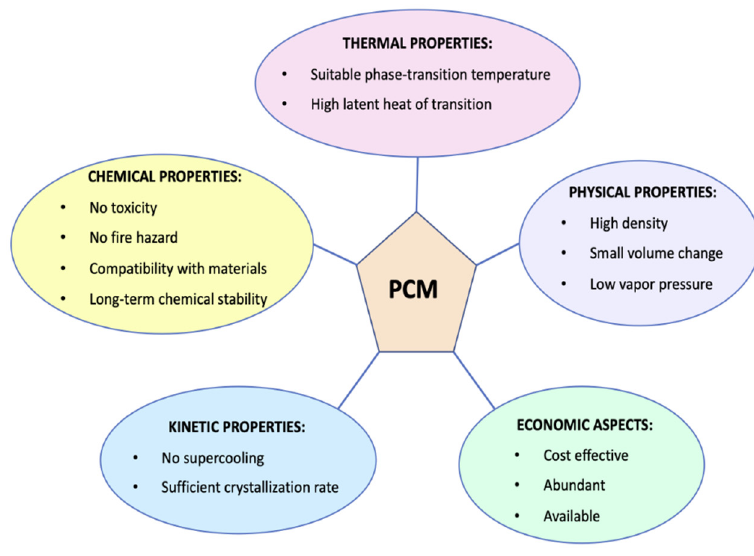
Figure 2. Main properties for ideal phase change material (PCM).